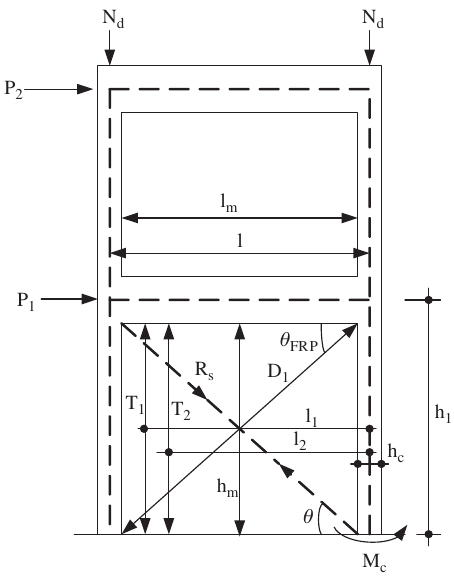
Figure 17 Forces acting on the specimens SA1.0-CV and SA1.7-